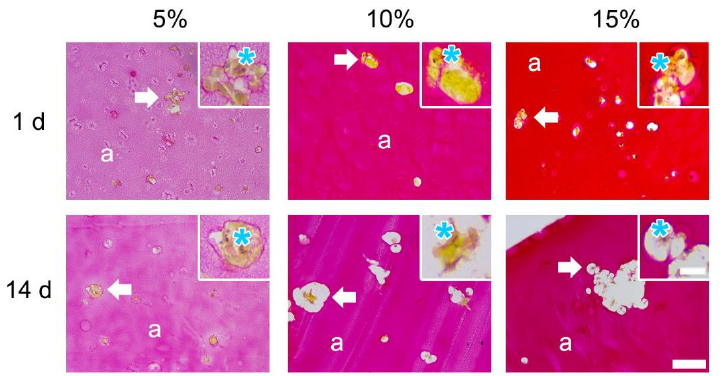
Figure 4. Picrosirius red stain of cell-loaded 5%, 10%, and 15% GelMA. Overview (Scale bar 100 µm) indicates the hydrogel (a) and the areas of clustered cells (white arrow). Such clustered areas are shown in the magnified view (Scale bar 25 µm); the cytoplasm of the cell and the nuclei are indicated with a cyan asterisk.